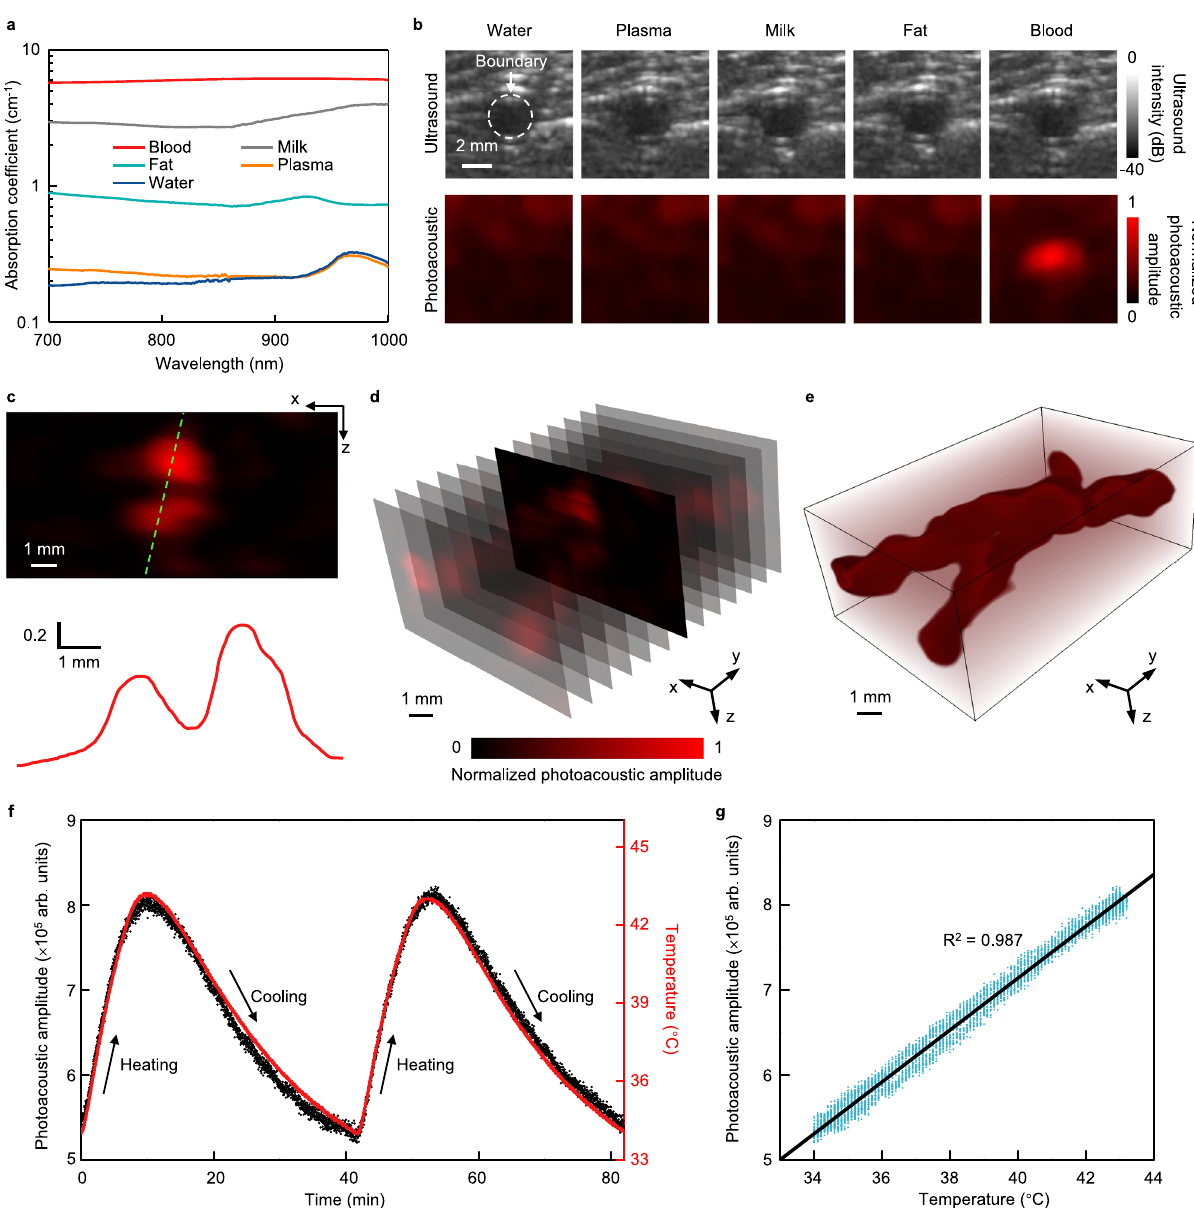
The red curve at the bottom panel shows the pro fi le along the green dashed line. d 13 slices of photoacoustic images of the blood vessel phantom with display transparency of 80%. e 3D imaging of hemoglobin at a depth of 2cm in porcine tissue. f Comparisonbetweenthebeamformedphotoacousticsignalamplitudeand temperature of fl owing blood during two cycles of heating and cooling. g Linear fi tting of the photoacoustic amplitude and